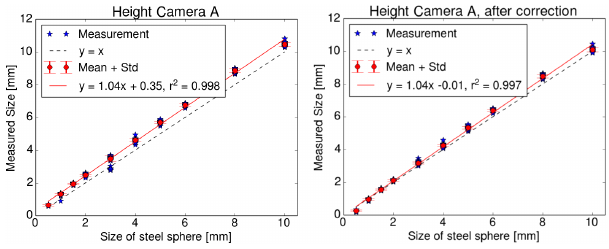
Figure 8. Comparison between nominal and measured height of calibration spheres before and after correcting the pixel width. Table 2. Results of the calibration measurements with steel spheres. m and t denote the slope and intercept of the regression line, respec- tively. r is the correlation coefficient. H A / B and W A / B are the width and height measured in camera A and